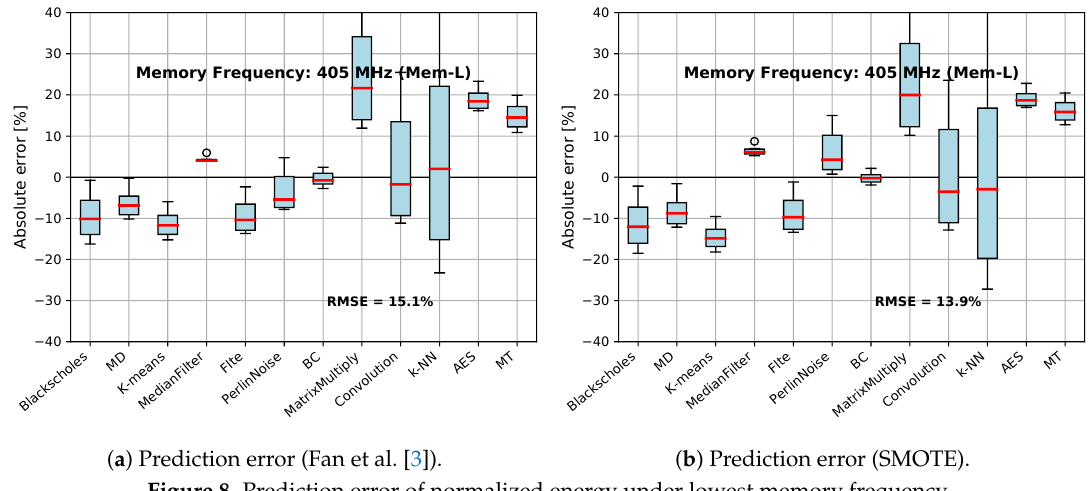
Figure 8. Prediction error of normalized energy under lowest memory